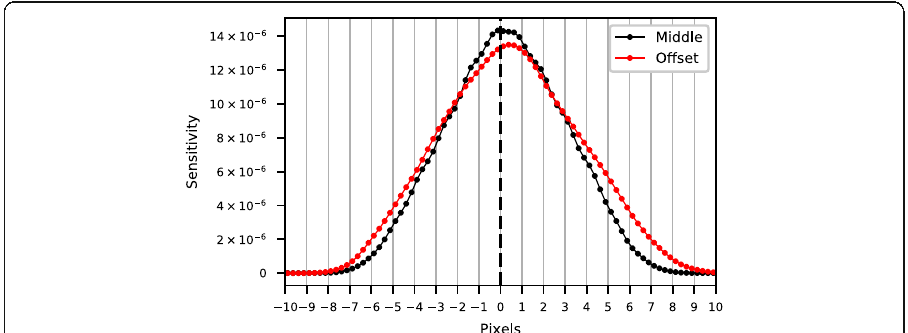
Fig. 4 Difference in point spread function for a point source located in the origin at z = 25 cm and one with an offset of dx = 10 cm. These PSFs were corrected for the 1/cos 2 ( θ ) sensitivity